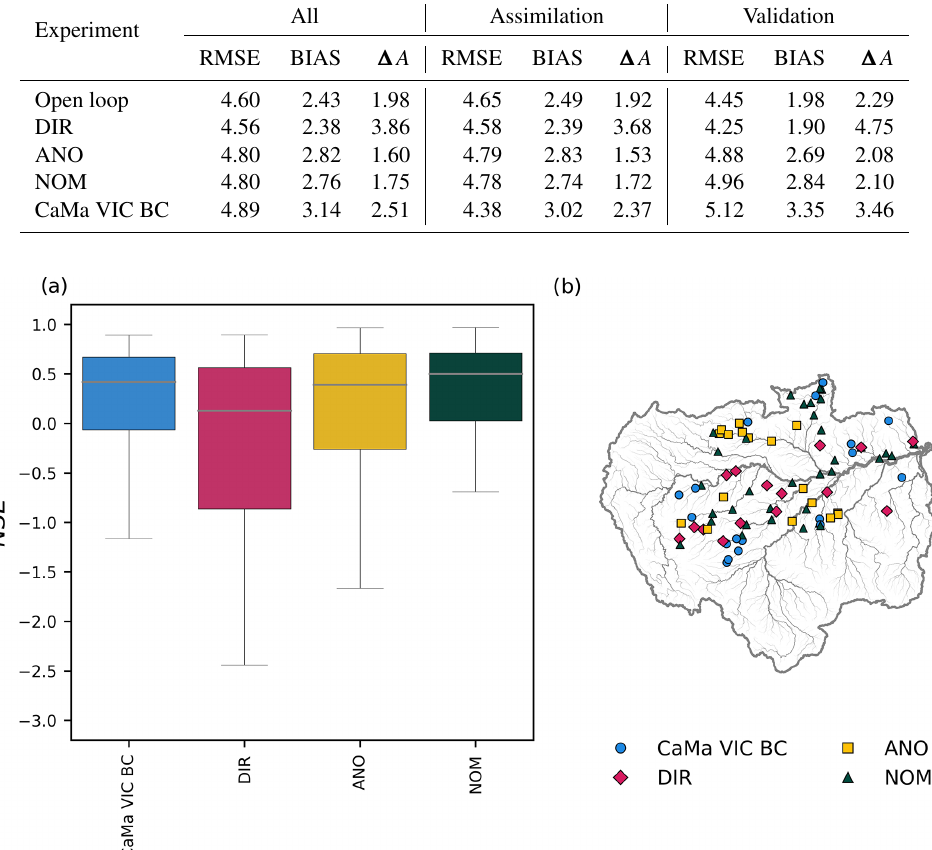
Figure 10. (a) Boxplot of Nash–Sutcliffe efficiency ( NSE ) for discharge simulated using CaMa-Flood with VIC bias-corrected runoff (CaMa-Flood VIC BC), ensemble mean assimilated river discharge with direct DA (DIR), ensemble mean assimilated river discharge with anomaly DA (ANO), and ensemble mean assimilated river discharge with normalized value DA (NOM). (b) Spatial distribution of the best discharge estimates among CaMa VIC BC, DIR, ANO, and NOM based on